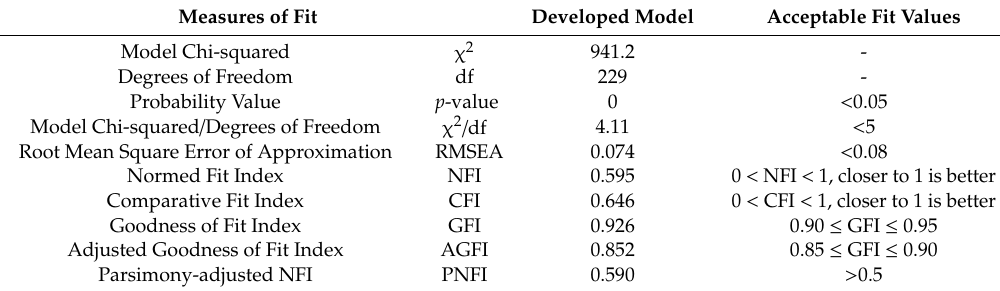
Table 5. Goodness-of-fit measures of the developed model.